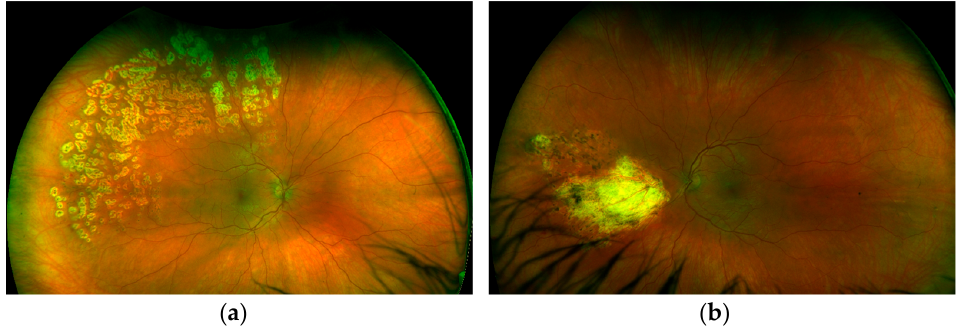
Figure 4 . Fundoscopic examination of left ( a ) and right ( b ) eye showing areas of laser